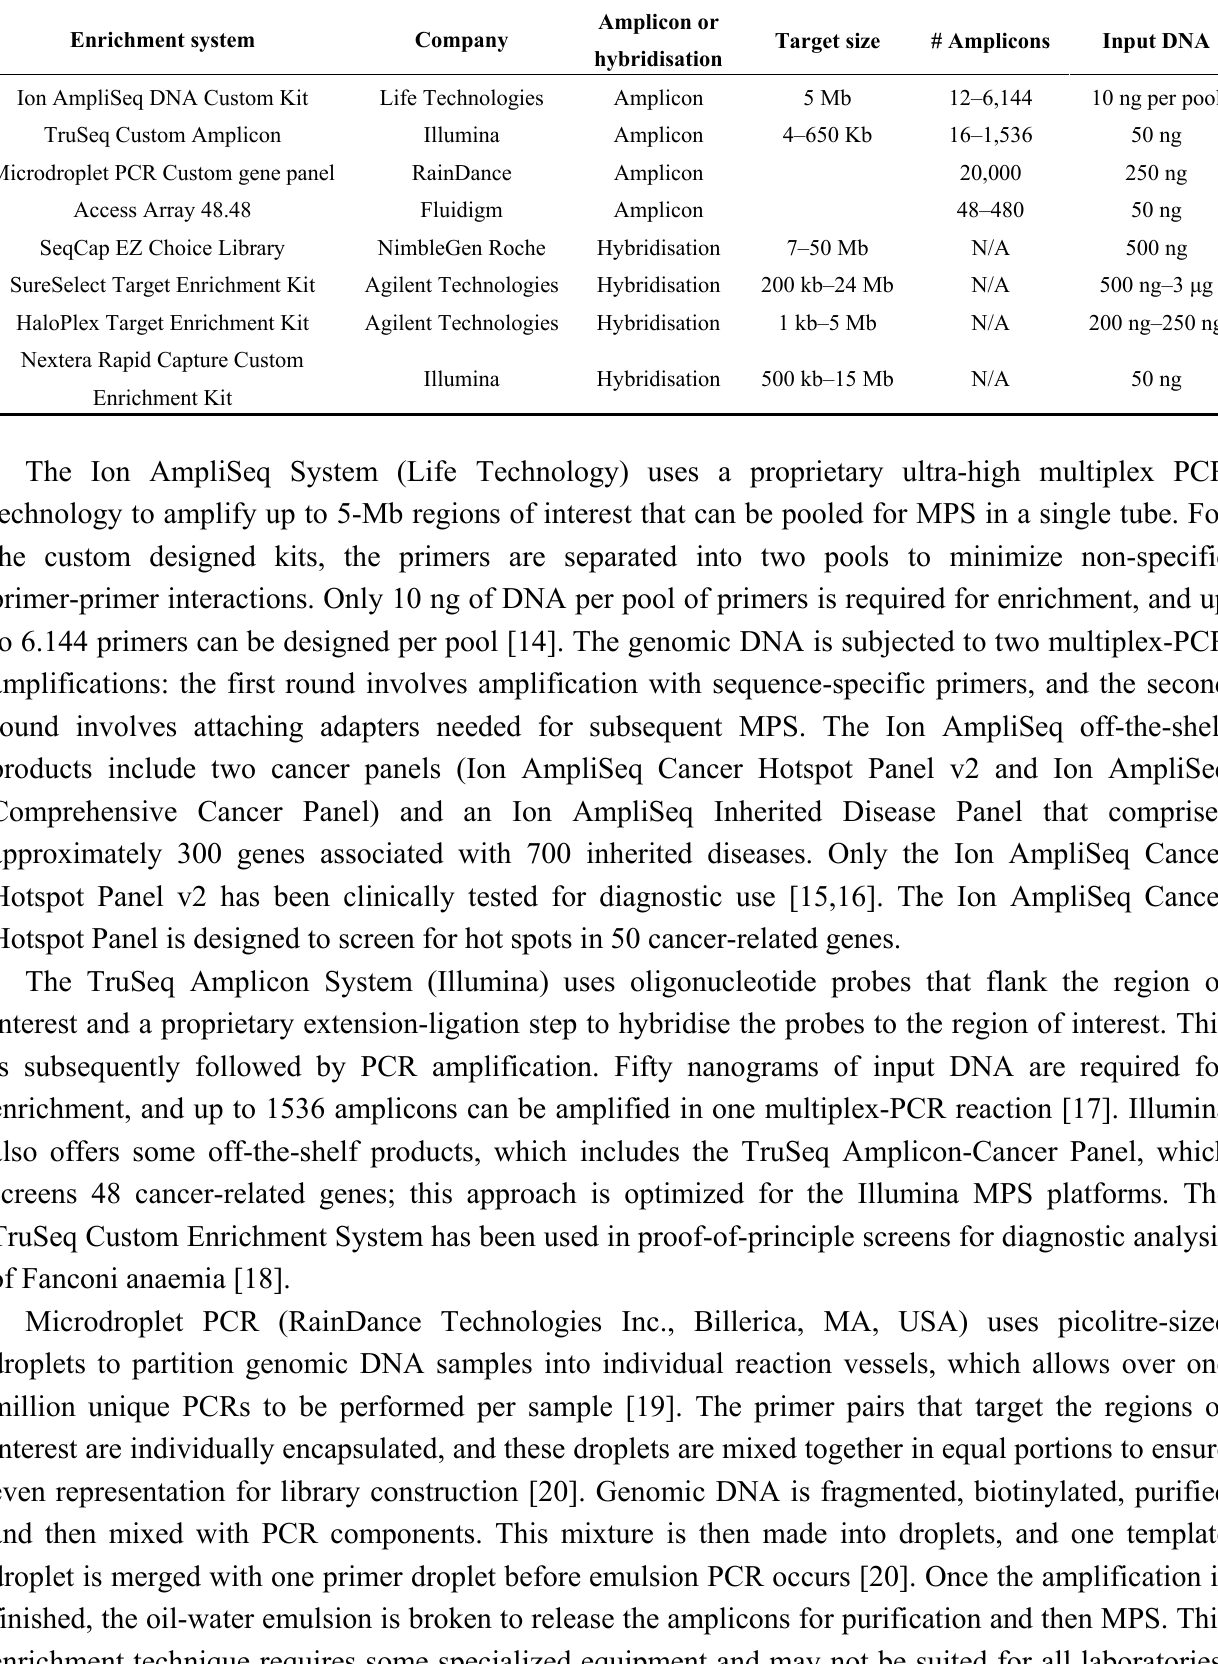
Table 1. Commercially available custom enrichment